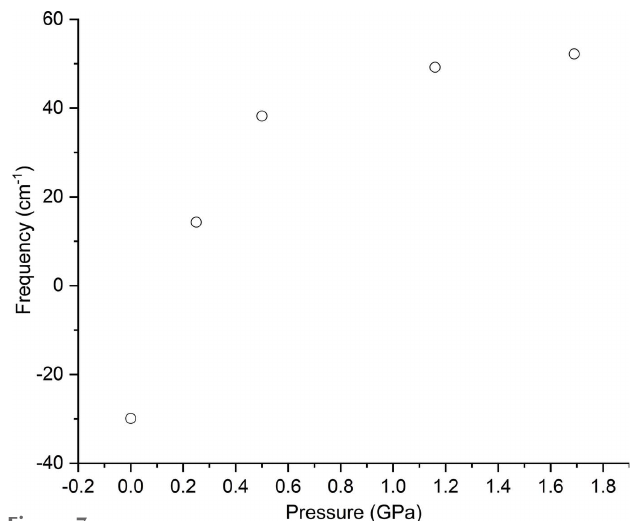
Figure 7 Variation of the frequency of the of the B 2 symmetry-breaking lattice mode as a function of pressure. Frequencies were calculated by periodic DFT; imaginary frequencies are shown as negative